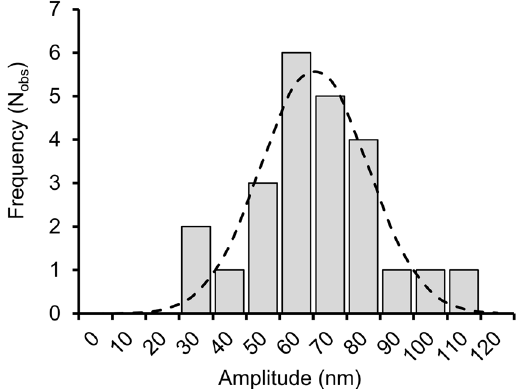
Figure 7. Fluctuations in DNA length with central oriD sequence after addition of RepDY188F. The amplitude of DNA length fluctuations due to alternation between B-state DNA and hairpin secondary structure formation was determined from the distance between the means used to fit the twin Gaussian distributions to the histogrammed bead height data. The average amplitude of the length fluctuations is 71.5 nm and standard deviation is 22.4 nm (least-squares fit to the data, dashed line). Given that 1 turn of writhe produces a 60 nm length change at 0.67 pN; the number of base pairs involved in the structural rearrangement = (71.5/60)